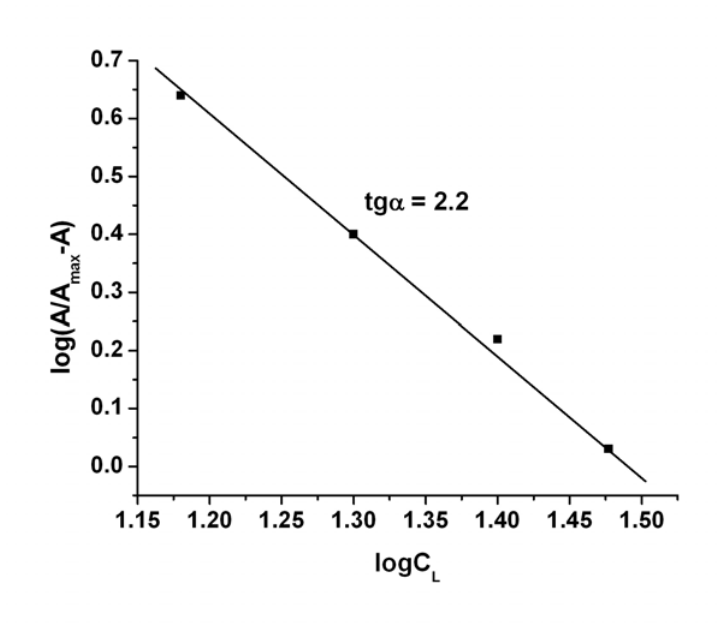
Fig. 1 Metal-to-ligand ratio in the mononuclear complex in methanolic